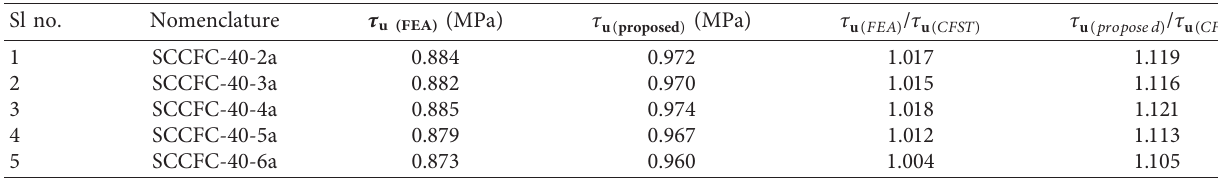
Table 5: Comparison of bond strength of numerical models with proposed formula. Sl